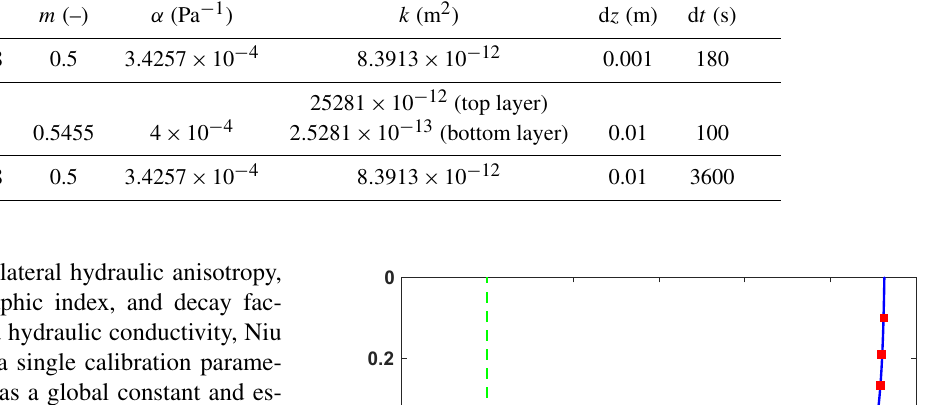
Table 1. Soil properties and discretization used in the three test problems described in Sect. 2.3. Problem